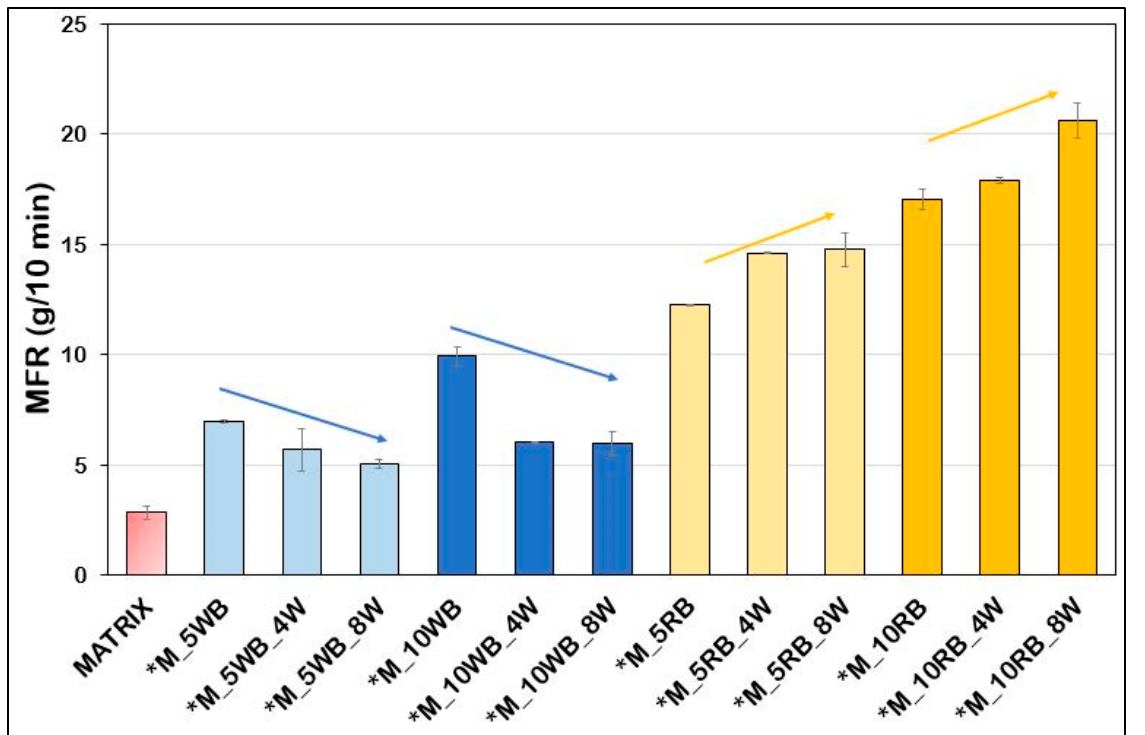
Figure 4. Melt flow rate behavior for the formulations with beeswax, showing opposite trends.